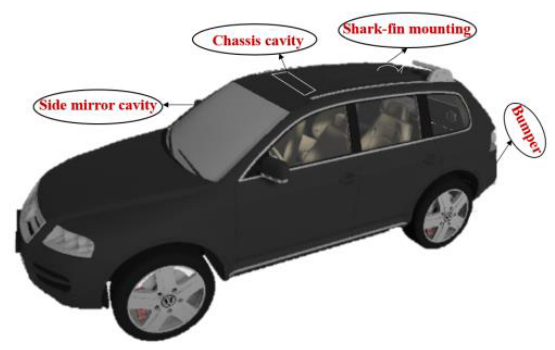
Figure 20. Different antenna mounting locations in a car.